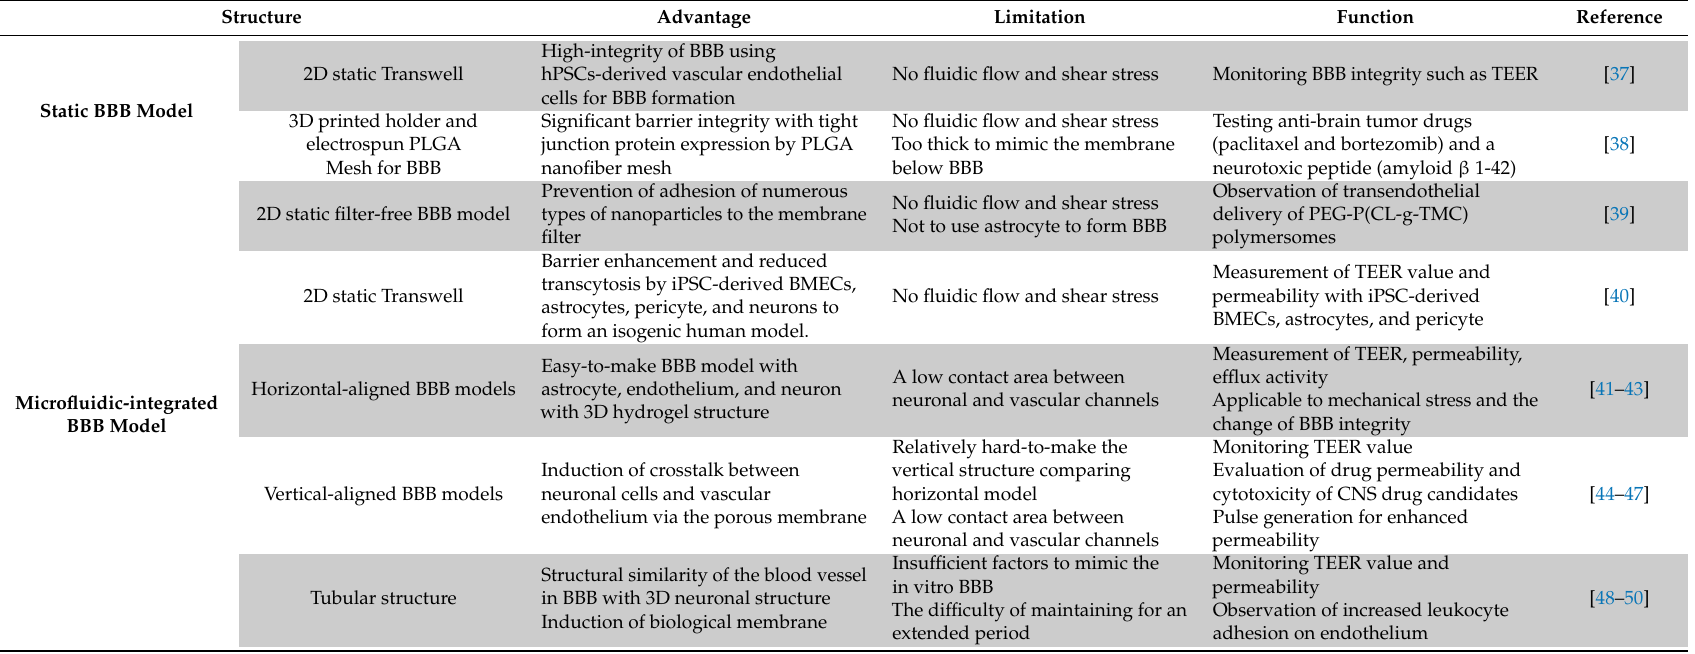
Table 1. Advantages and limitations of current in vitro BBB